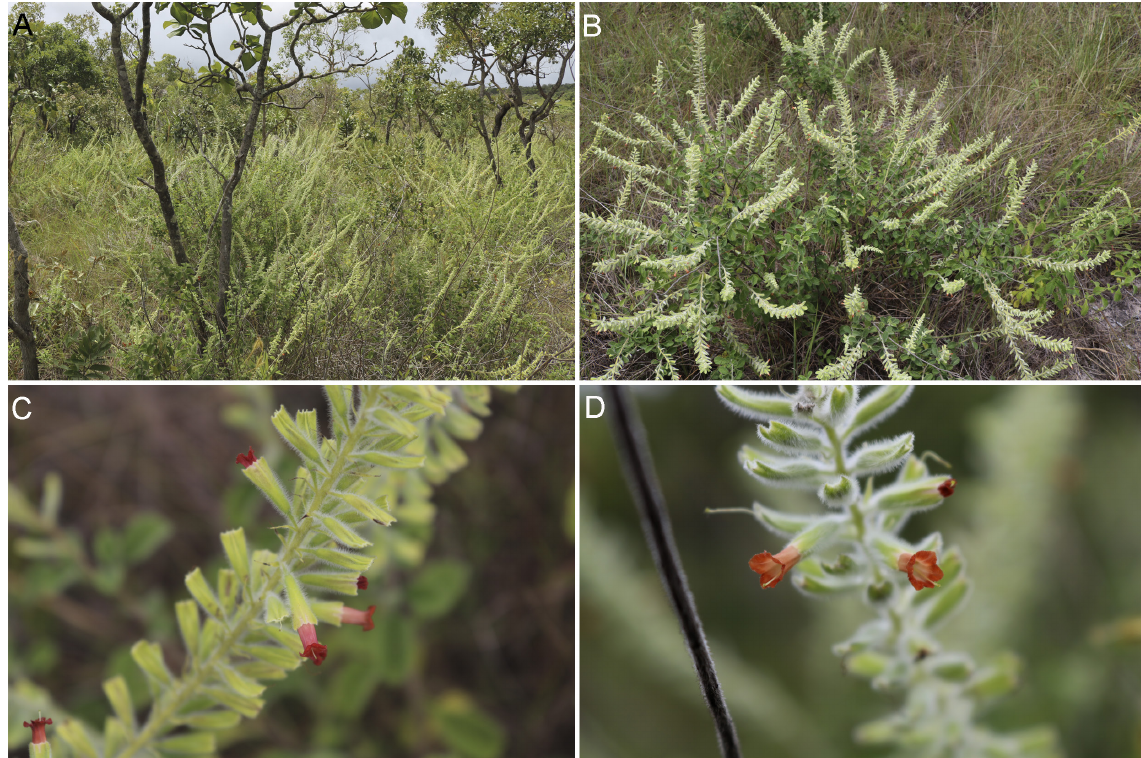
Fig. 10. Stachytarpheta longipedicellata (Moldenke) P.H.Cardoso comb. and stat. nov. A . Habitat. B . Habit. C–D . Individuals showing details of the inflorescences, highlighting the pubescence of the inflorescence, long pedicels, bracts, calyxes, and corollas. Photos by Pedro Henrique